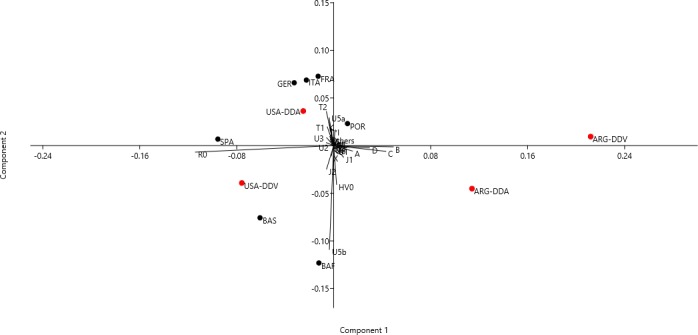
PCA based on mtDNA haplogroup frequencies in Basque Diaspora and European populations.Haplogroups and subhaplogroups included in the PCA biplot are R0 (including H subhaplogroups), HV0, J*, J1, J2, T*, T1, T2, U*, U1, U2, U3, U4, U5, U5a, U5b, U6, U7, U8, K, I, X, W, N, M, L, A, B, C, D, and others. Populations included are as follows: Basque Diaspora populations (in red) from USA (USA-DDV and USA-DDA) and Argentina (ARG-DDV and ARG-DDA), Basque populations from Spain (BAS) and France (BAF),France (FRA), Germany (GER), Italy (ITA), Portugal (POR), and Spain (non-Basque included) (SPA).